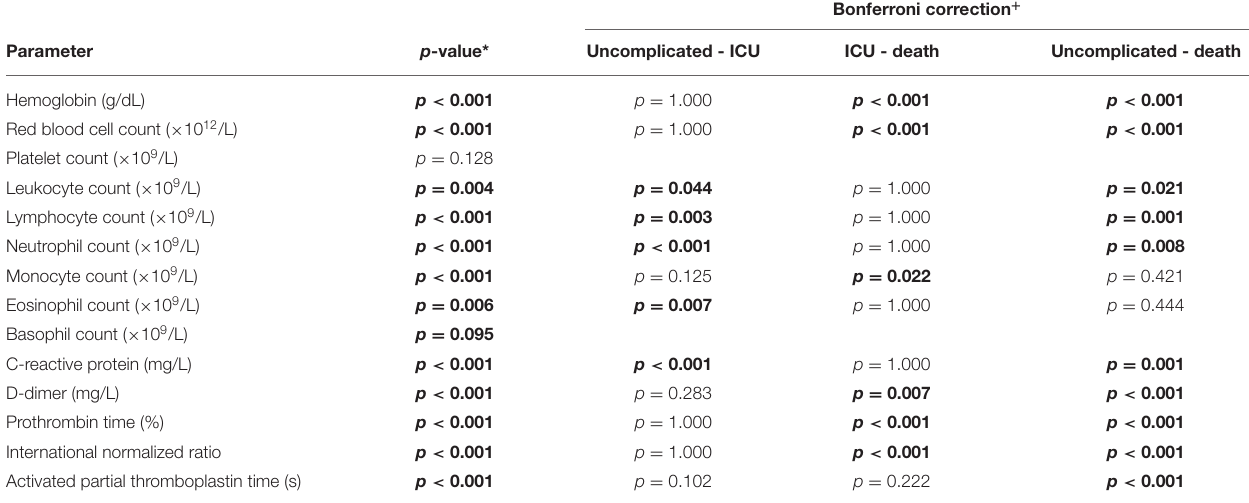
TABLE 3B | Statistical analysis of laboratory findings at admission (retrospective